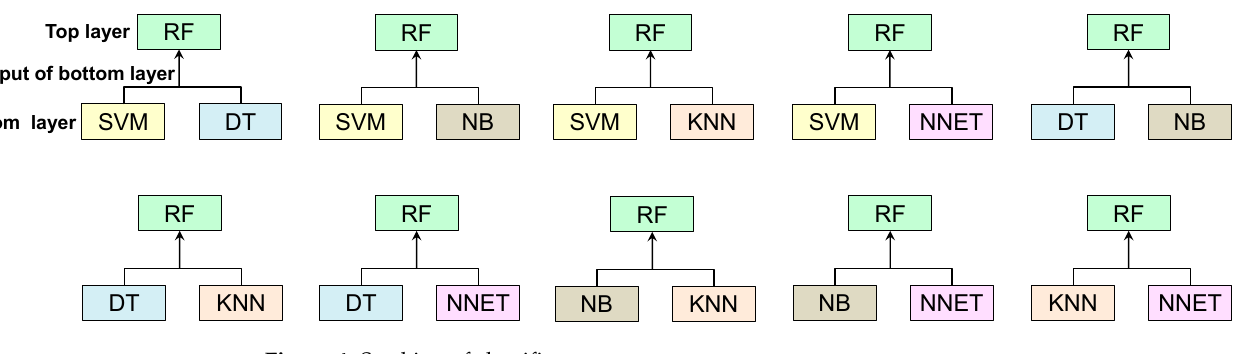
Figure 4. Stacking of classifiers.